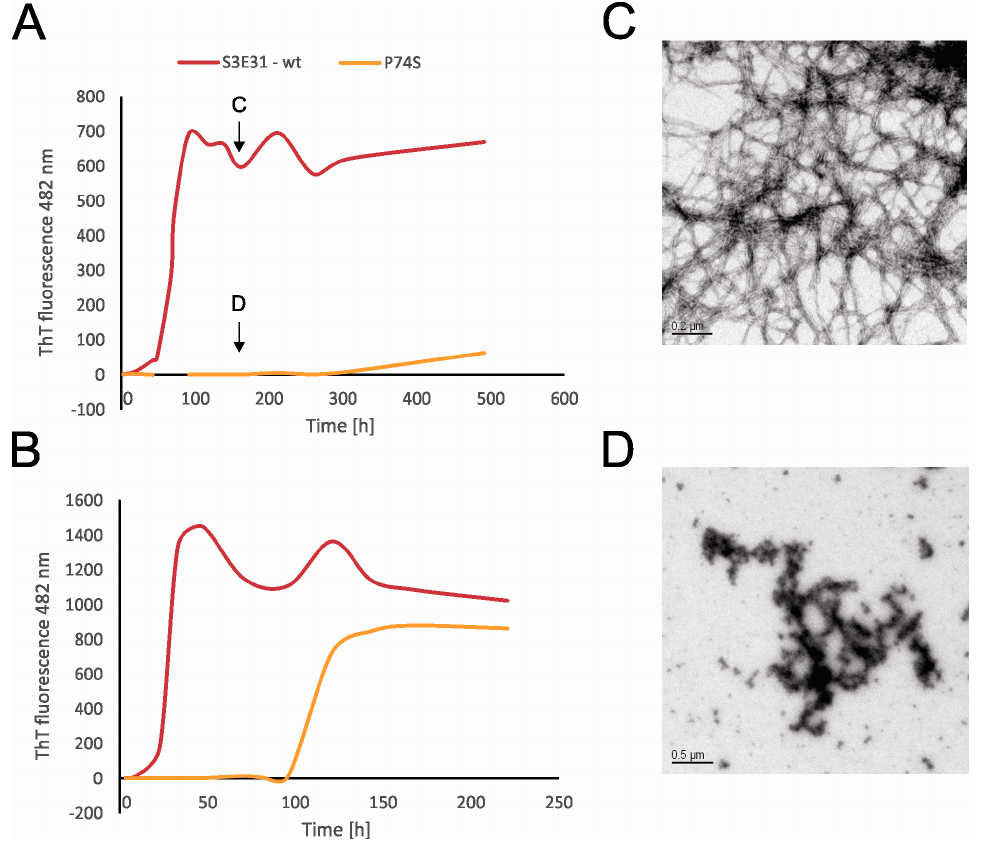
Figure 4. The time courses of amyloid fibril formation of wild-type stefin B and its site-specific mutant P74S were monitored by ThT fluorescence at 482 nm. The fibrillation reactions took place in 0.015 M acetate buffer, 0.15 M NaCl, pH 4.8, 12% TFE at 25 °C ( A ) and in the same buffer at 30 °C ( B ). TEM images taken during the fibrillation reactions. The wild-type stefin B ( C ) and P74S mutant ( D ) on the 7th day of fibrillation (see arrows) [20].